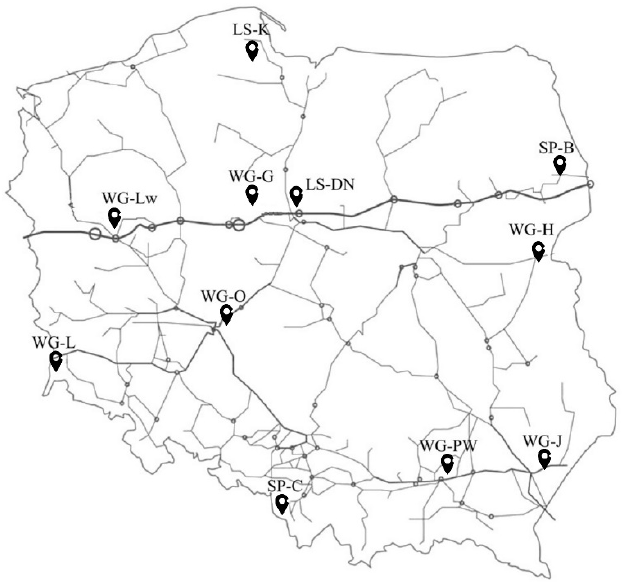
Figure 1. Location of measurement points (SP—a gas station; WG—a gas hub; LS—a launching station). 84